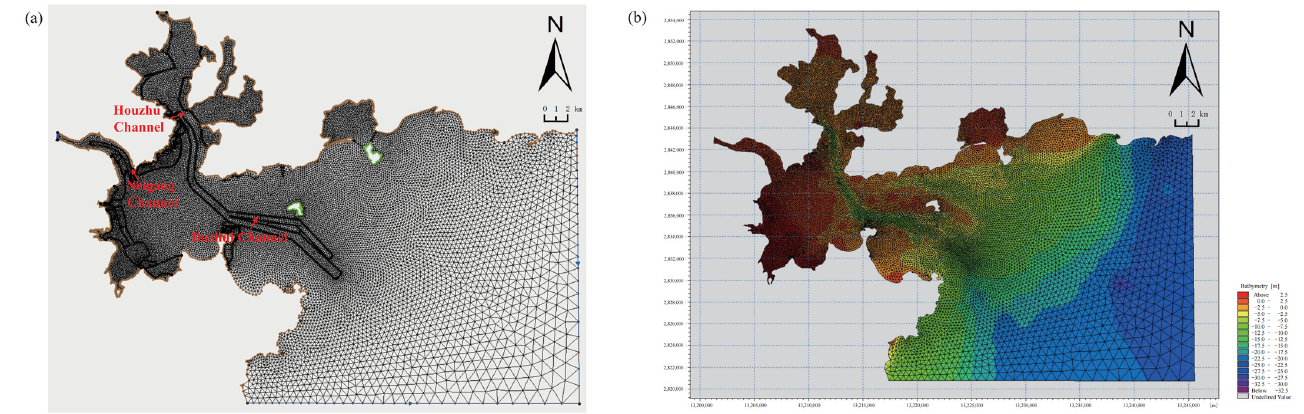
Figure 2. Mesh generation of the model. ( a ) Grid division of study area; ( b ) Bathymetric topography of the study area in 1954. Table 1. Status of the historical marine map data.